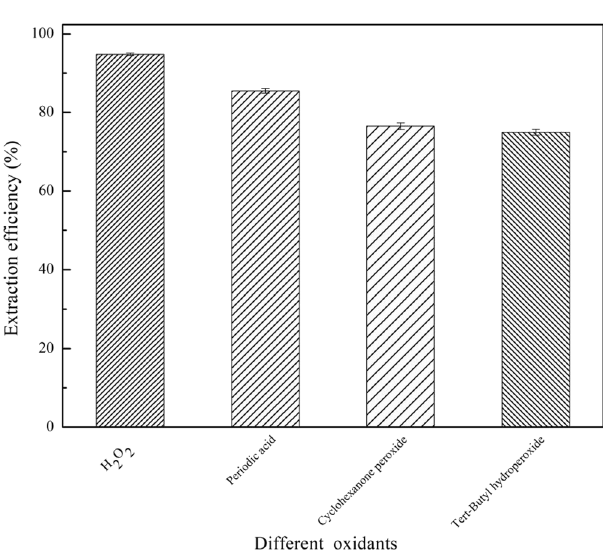
Figure 3. The effect of different oxidants on the extraction efficiency (experimental conditions: 1.2 g (TBAC/2p-TsOH)/rGO, 0.5 g simulated oil (1600 mg/L sulphur content), 25 °C, 800 rpm, 60